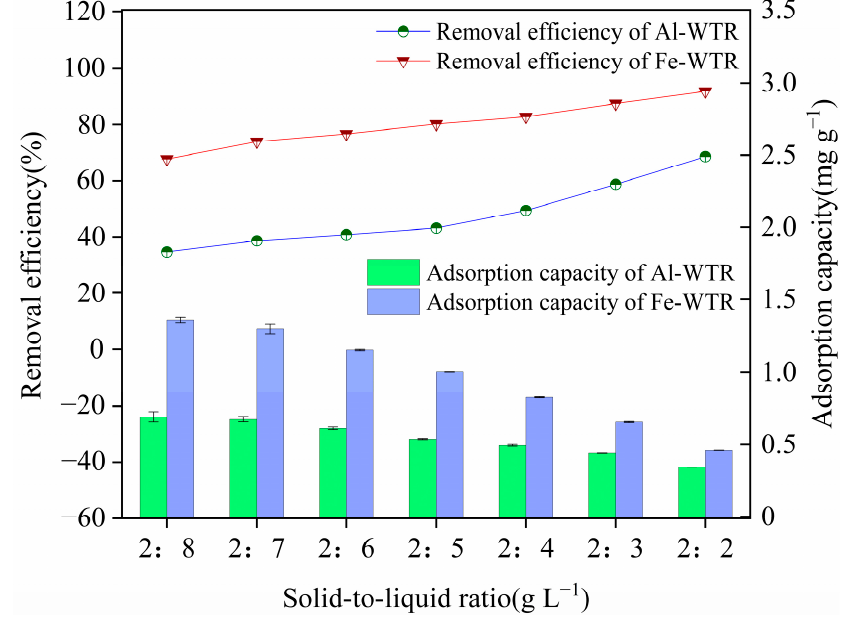
Figure 6. Effects of different solid–liquid ratios on adsorption of Tl(I) by Fe-WTR and Al-WTR.